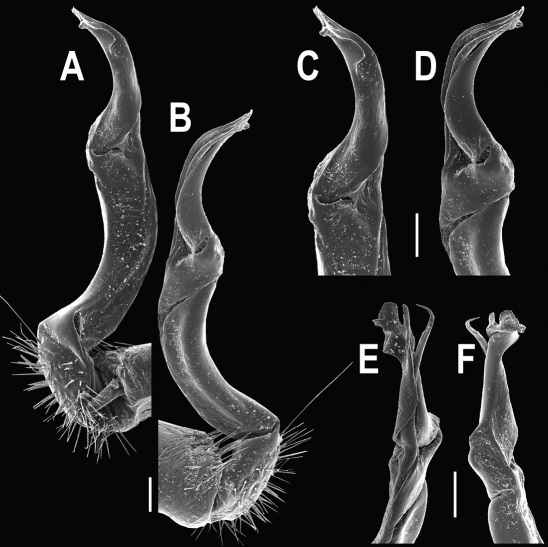
Orthomorpha pterygota Golovatch, 1998, ♂ from Panwa Cape. A, B right gonopod, mesal and lateral views, respectively C–F distal part of right gonopod, mesal, lateral, subcaudal and suboral views, respectively. Scale bar: 0.2 mm.